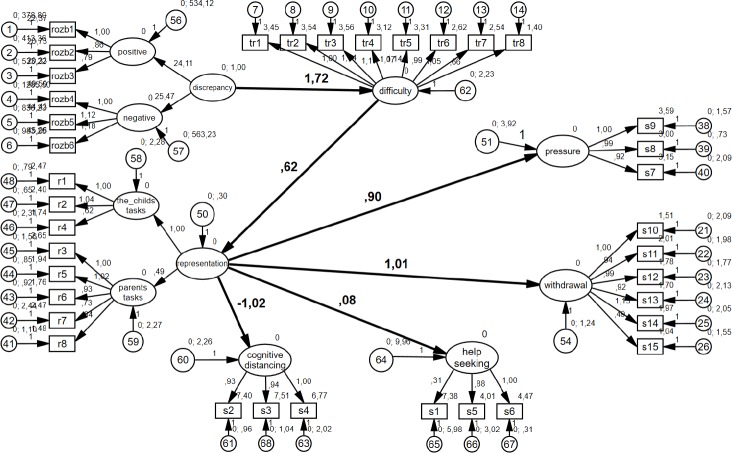
Graphical representation of the model.Non-standardized results.